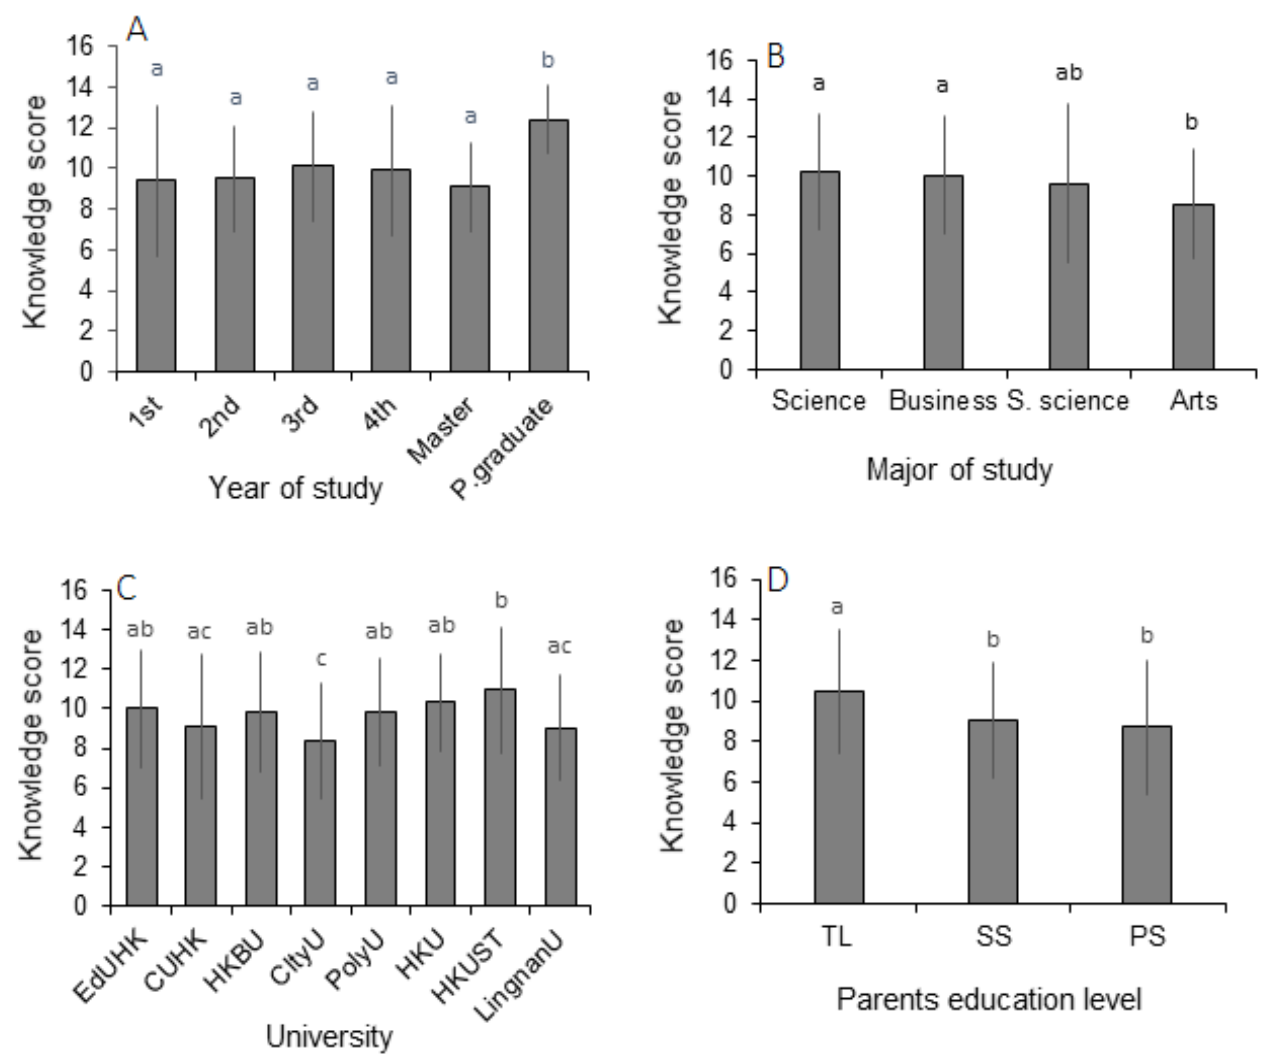
Figure 1. General marine environmental knowledge score (Mean ± SD) of students depending on different demographic variables: ( A ) year of study; ( B ) major of study; ( C ) major institution of study; ( D ) parents’ education level. Bars with different letters are significantly different (one-way post hoc LSD test; 95% level of confidence). TL = tertiary level of study, SS = secondary level of study, PS = primary level of study.